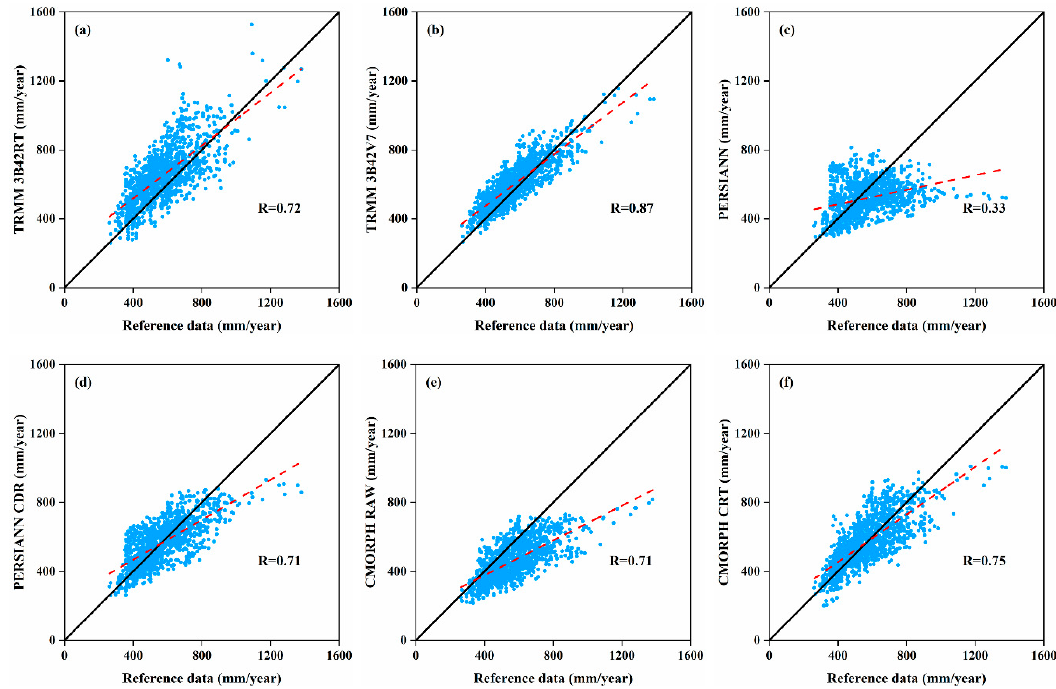
Table 4. SPP evaluation results at an annual scale at a grid scale.